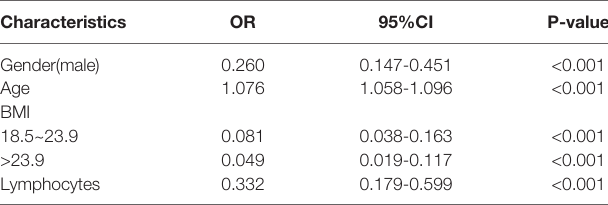
TABLE 2 | Multivariate logistic regression analysis.